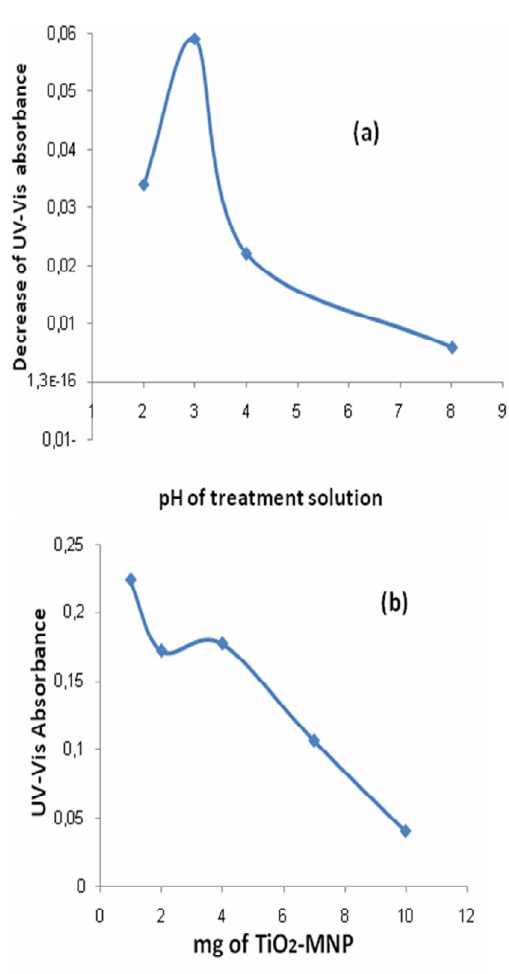
Fig. 5. The effect of different (a) pH values and (b) amounts of Fe O @SiO /TiO on treatment 3 4 2 2